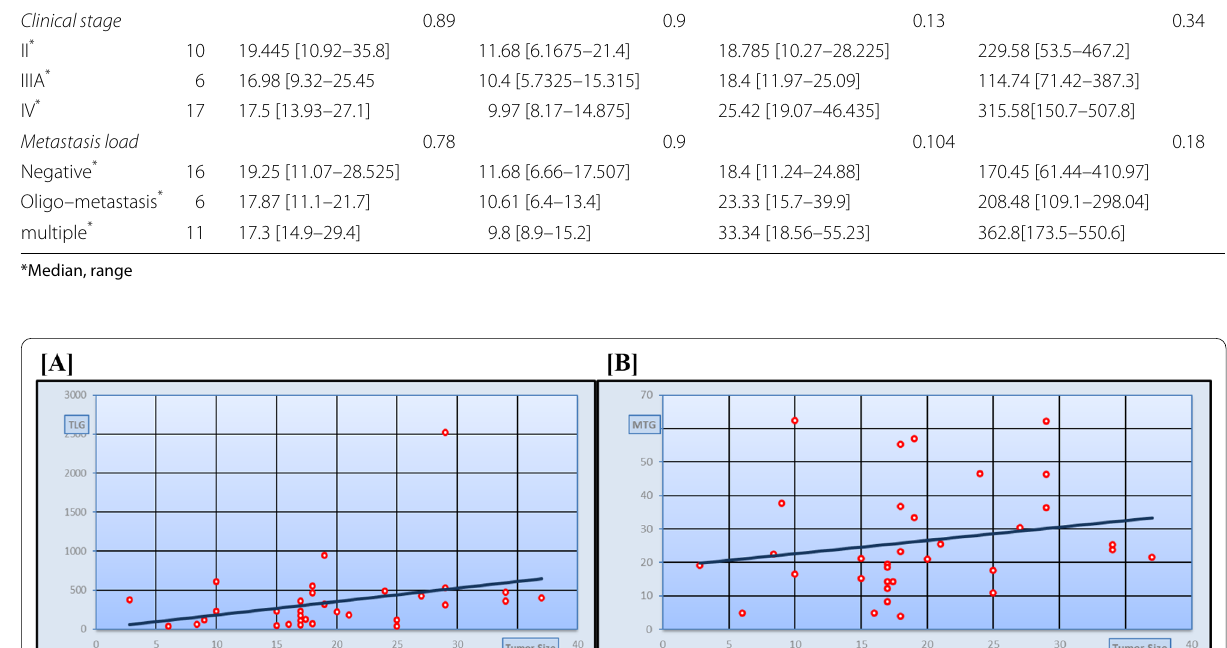
Fig. 5 The correlation between the metabolic parameters and size of the rectal